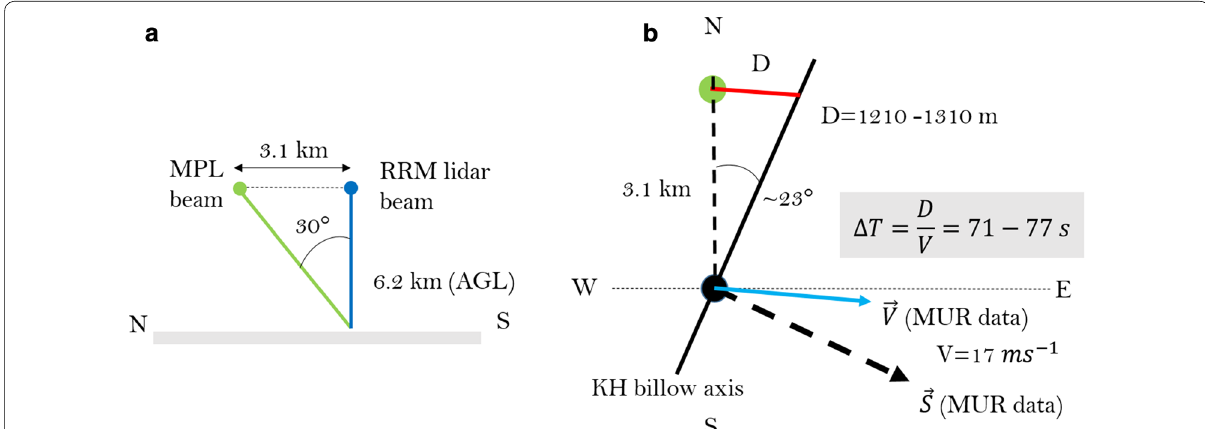
Fig. 8 a A sketch of the MPL and RRM lidar beams along the north–south axis. At the altitude of 6.2 km AGL (~ 6.6 km ASL), the two instruments detected the mean altitude of the KH billows at a horizontal distance of ~ 3.1 km. b The corresponding sketch in the horizontal plane. The KH billow axis was obtained from the fish-eye camera photographs (Fig. 12). According to the wind measurements taken by the MU radar, the RRM lidar detected the same KH billows as MPL about 71–77 s later (but not at the same location along the billow axis). It is consistent with the time correction applied in Fig.